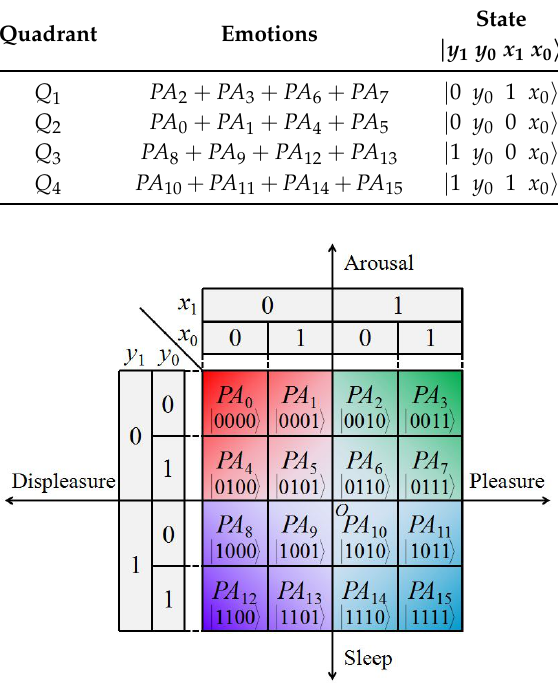
Figure 4. Description of 16 common states of a robot’s emotions in QPA